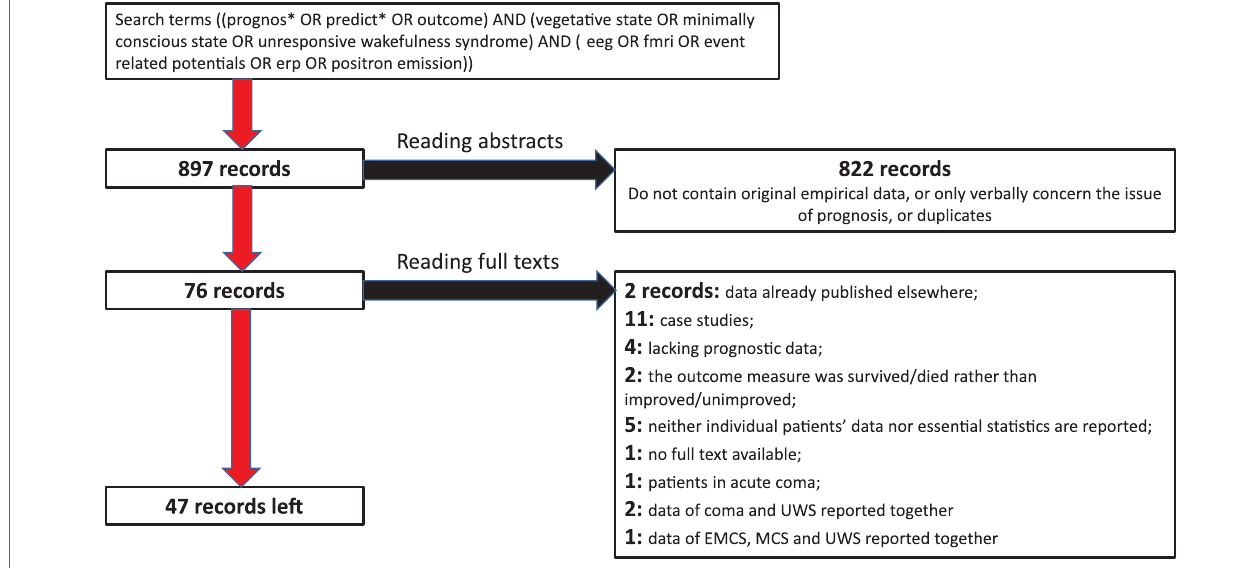
FiguRe 1 | Flow chart of the selection of